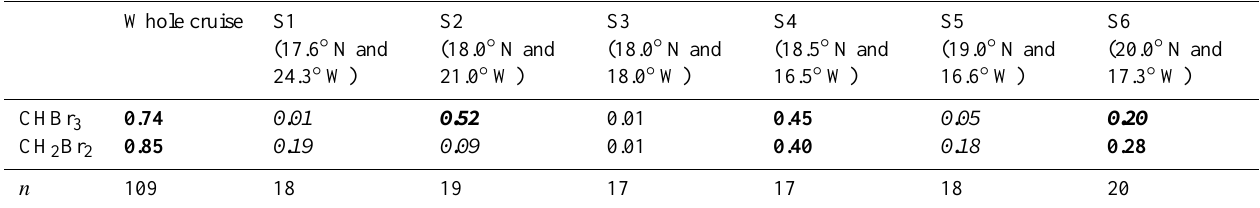
Table 6. Correlation coefficients R 2 and number of data points n of oceanic versus atmospheric bromocarbons for the whole cruise and each individual station. Bold numbers indicate significant correlations with p <0.05. Italic numbers mark negative